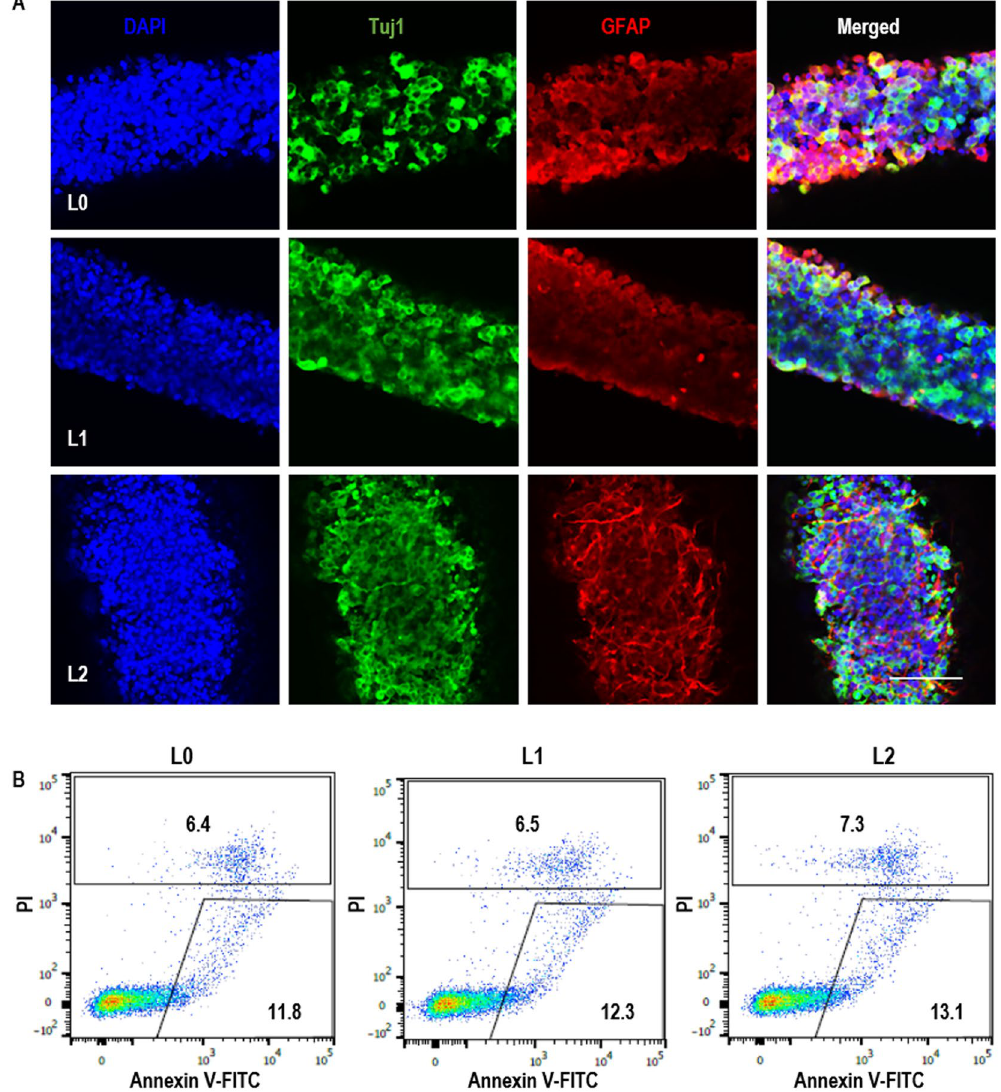
Figure 4. In vitro differentiation of glioblastoma TICs. ( A ) After 10 passages in AlgTubes, L0, L1 and L2 were spontaneously differentiated in AlgTubes for 2 weeks. Fibrous cell masses were fixed for staining. All TICs could be differentiated into Tuj1 + neurons and GFAP + glial cells. (B ) After 10 passages in AlgTubes, L0, L1 and L2 were cultured for 7 days after removing bFGF from the culture. Cell death was evaluated by Annexin V and PI staining for L0, L1 and L2. Scale bar: 100 µ